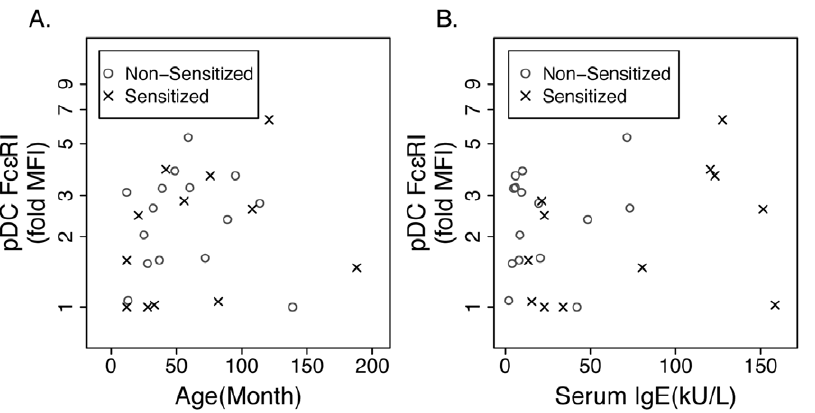
Figure 3. Expression of Fc e RI on pDC does not correlate with serum IgE or age of subject. Expression of Fc e RI on peripheral blood pDC was determined by flow cytometry and compared to subject’s age (panel A) and serum IgE level (panel B). Data are presented as in Figure 1.